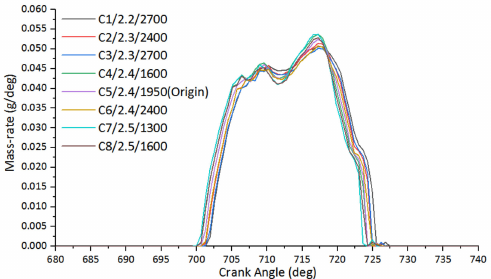
Figure 31. Volume optimization plan for mass rate.